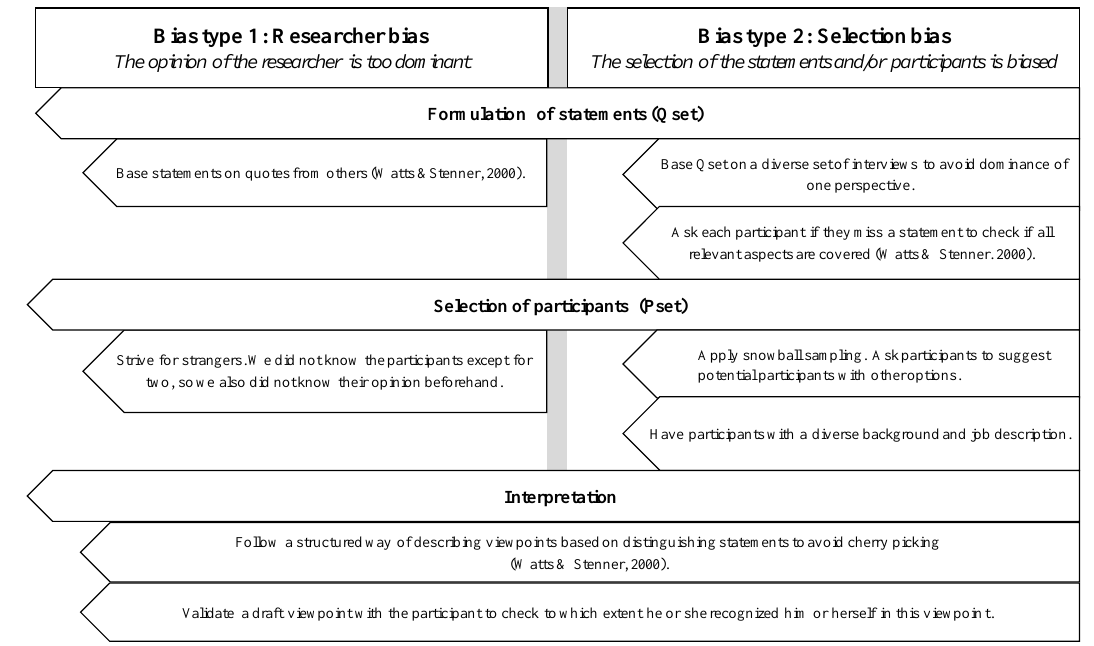
Figure 3. A summary of the mechanisms used to reduce bias. In two columns actions are listed to reduce researcher bias (left) and selection bias